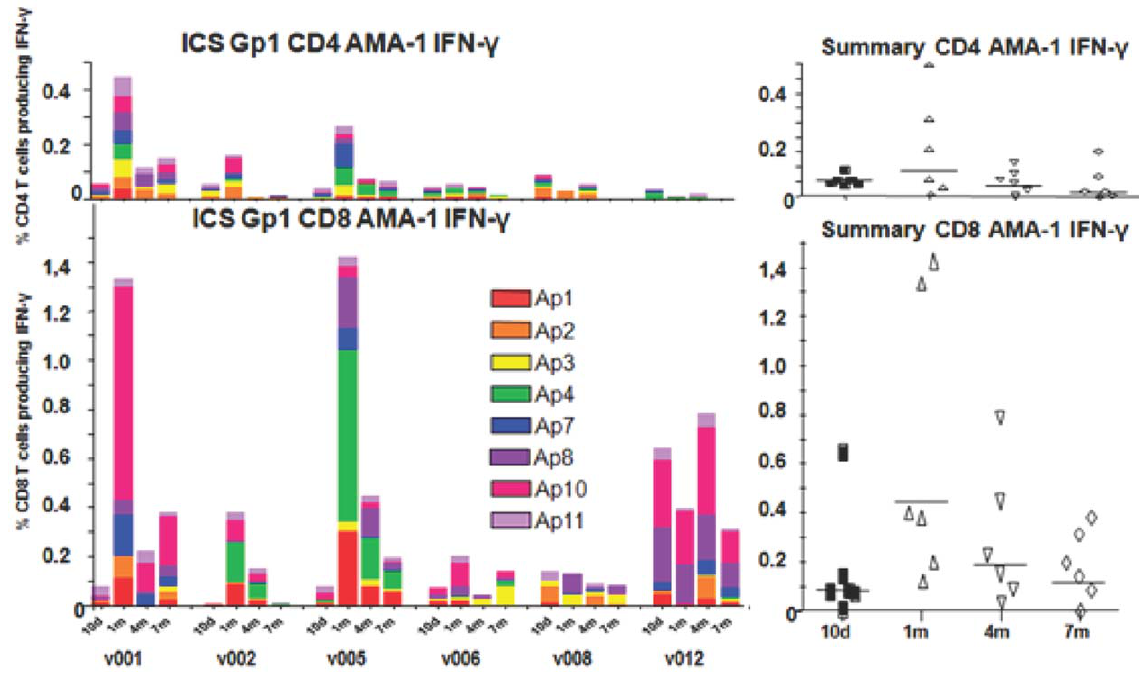
Figure 8. T-ICS CD4 + and CD8 + IFNactivity of serial bleeds of each volunteer in Group 1 with AMA1 peptide pools. Eight Ap peptide pools that were most strongly recognized in ELISpot assays were used to determine ICS CD4 + and CD8 + IFN- c activity. The ICS CD4 + and CD8 + T cell activities of each volunteer at 10 days and 1, 4, and 7 months (subtracting pre-immunization values) are displayed using color-coded AMA1 peptide pools. Scales for each phenotype have been equalized to emphasize the lower CD4 + responses. The inserts show the values of the sum of each volunteer’s responses at each time point and the bar indicates the geometric mean of the group. At 1 month, CD8 + responses (geomean 0.44% CD8 + T cells, std dev 0.58) were higher than CD4 + T-INF- c responses (geomean 0.086% CD4 + T cells, std dev 0.17).